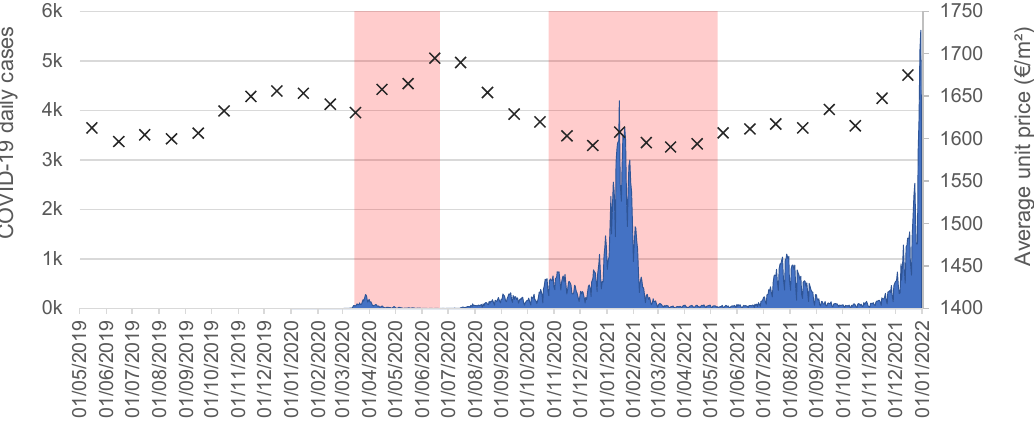
Figure 3. ( left axis ) Number of COVID-19 cases reported daily to the RENAVE Network in the province of Alicante (Source: own elaboration based on data from [44] ). ( right axis ) Average unit price of multifamily house in €/m² by months (Source: own elaboration).